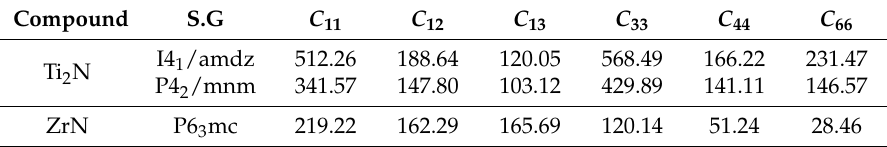
Table 4. Elastic stiffness constants C ij (GPa) of Ti 2 N and ZrN with space group P6 3